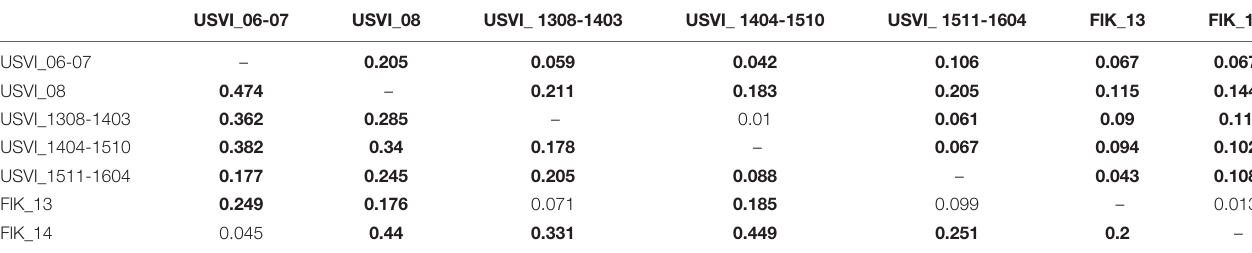
TABLE 3 | F ST values calculated based on genomic microsatellites (above the diagonal) and based on microsatellites discovered from the transcriptome (below the diagonal).